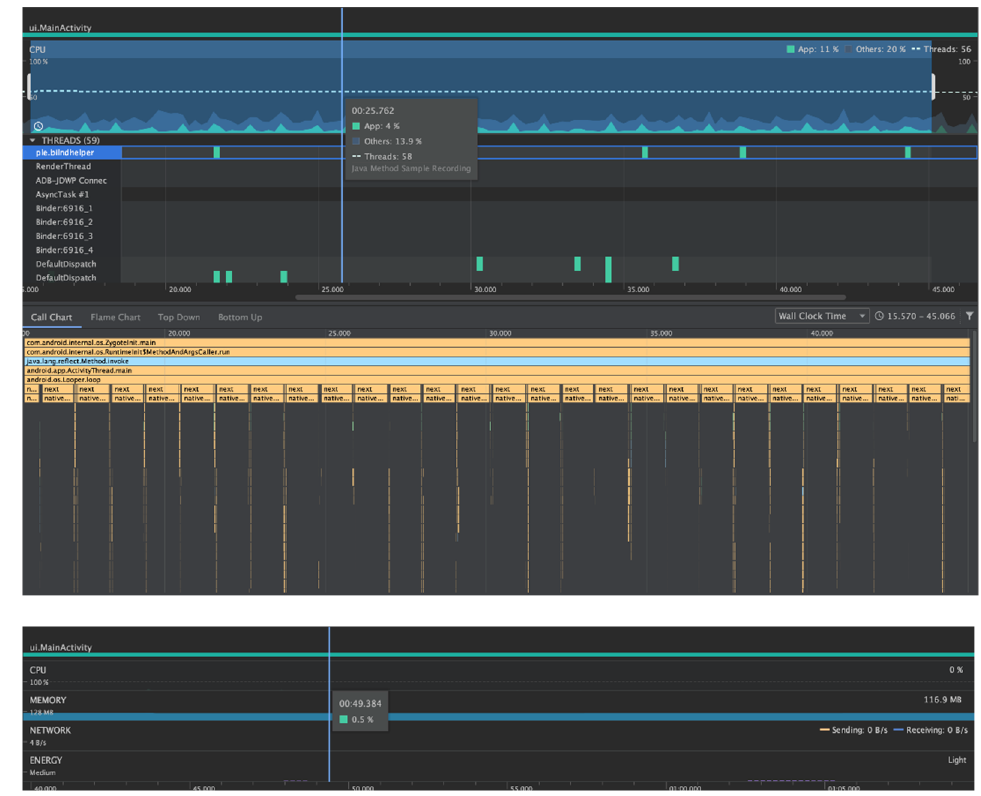
Figure 13. Median-4 filter CPU, memory and power load.